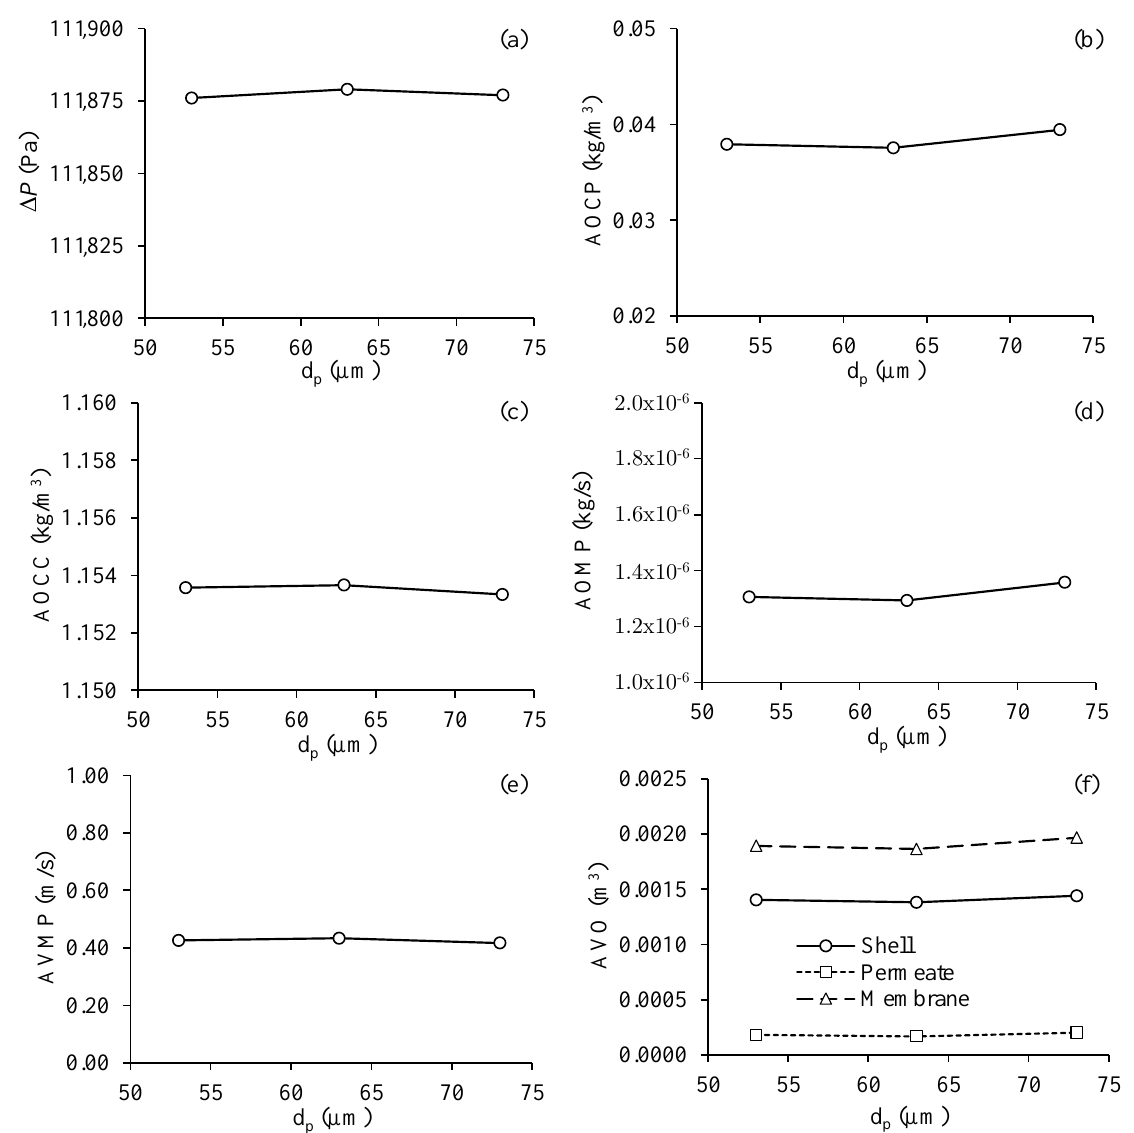
Figure 12. Process parameters in the filtration module as a function of the diameter of the oil drop. ( a ) Transmembrane pressure, ( b ) average oil volumetric concentration at the permeate outlets, ( c ) average oil volumetric concentration at the concentrate outlet, ( d ) average oil mass flow rate at the permeate outlets, ( e ) average fluid velocity in the permeate outlets and ( f ) average volume of oil present in the hull, membranes and permeate (Cases 5, 8 and 9).